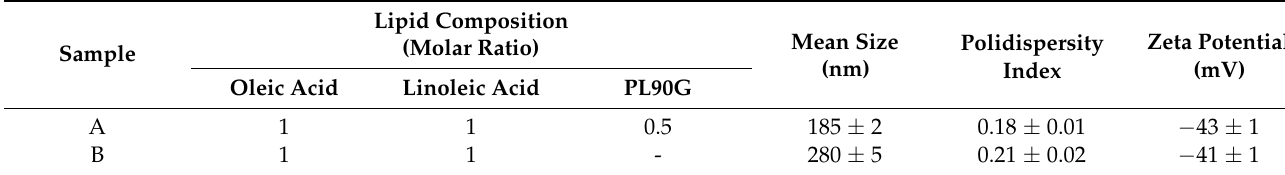
Table 2. Physicochemical and technological characterization of ufasomes.